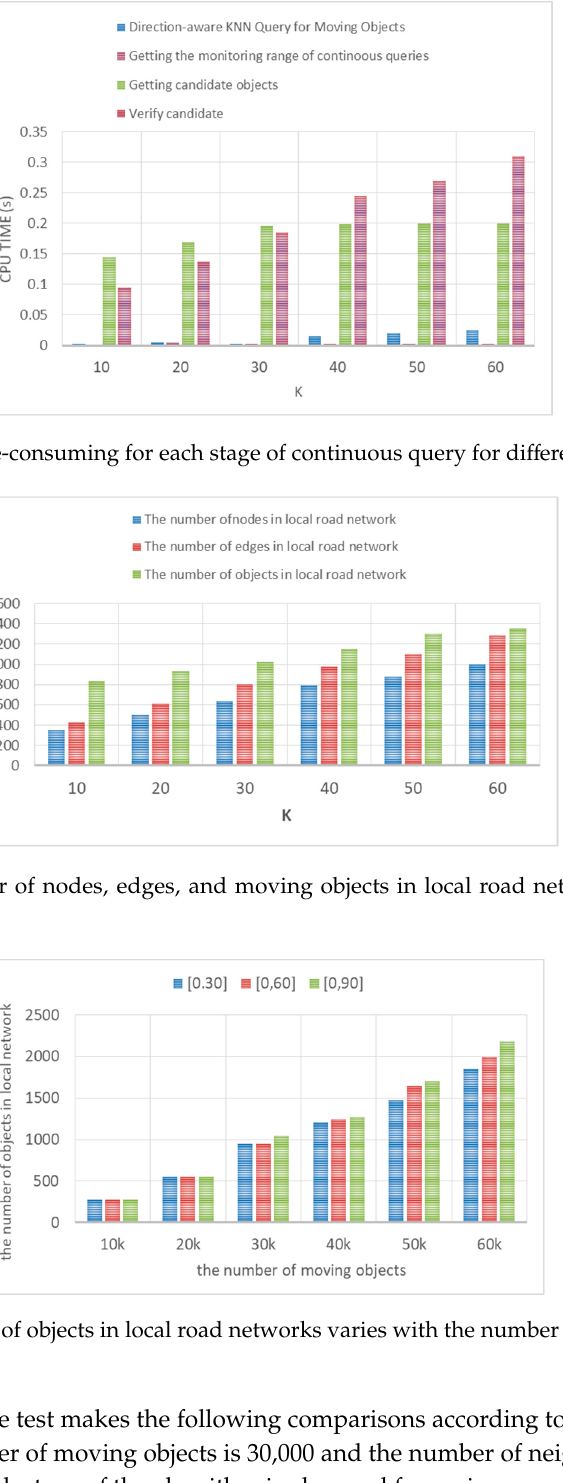
Figure 13. Effect of different time intervals on performance.